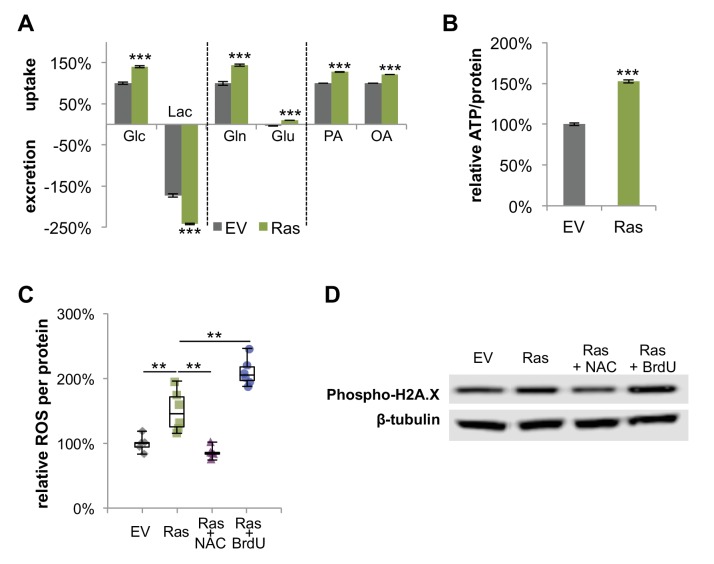
H-Ras transformed fibroblasts have increased metabolic activity, elevated levels of ROS, and DNA damage.(A) Ras cells have increased glucose uptake and lactate excretion compared to proliferating EV controls. Ras cells also exhibited altered profiles for glutamine, glutamate, and fatty acid consumption (n = 4). (B) Ras cells have higher intracellular ATP levels than EV controls. ATP luminescence signals were normalized to protein amount (n = 5). (C) Intracellular ROS was measured by using a DCFDA assay and normalized to protein amount. Negative controls (Ras +NAC) were treated with NAC, a ROS scavenger for 48 hr. Positive controls were treated with BrdU to induce oxidative stress for 48 hr (n = 6). (D) DNA damage was determined by measuring the protein amount of phospho-histone H2A.X (Ser139). Data are presented as mean ±SEM. **p<0.01, ***p<0.001.